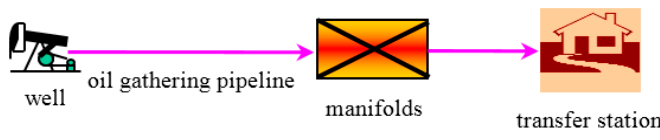
Figure 2. Illustration of oil gathering process.